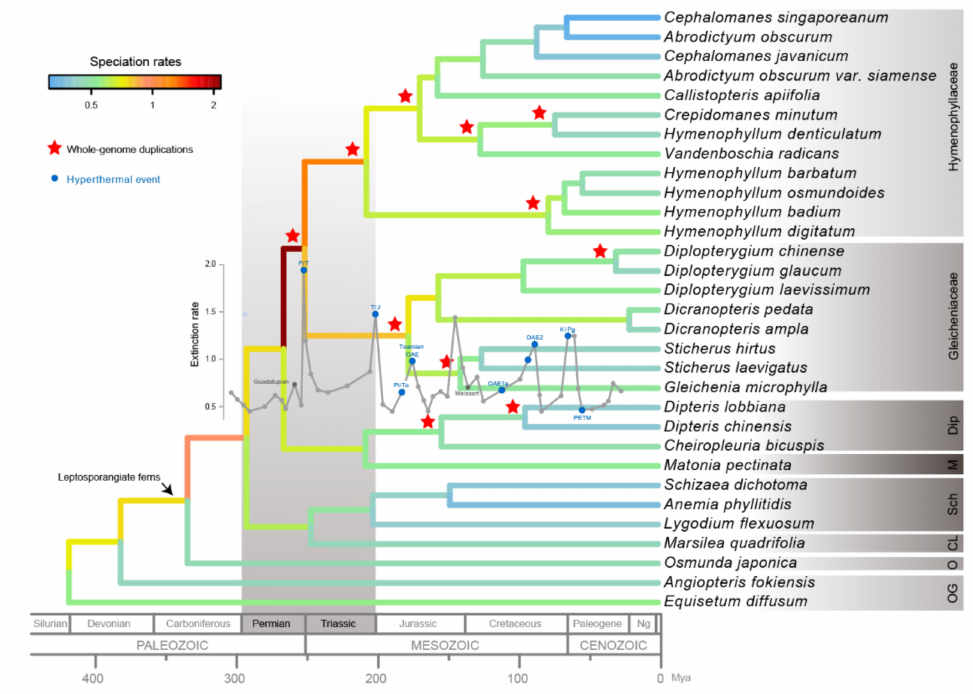
Figure 4. The evolutionary history of early leptosporangiate ferns. The bootstrap support (BS) value of each branch is 100 (not indicated in the species tree). The extinction rate was sourced from Clapham and Renne (2019). The red stars indicate the inferred whole genome duplication events. Abbreviations: K/Pg, end-Cretaceous; OAE, oceanic anoxic event; PETM, Paleocene–Eocene Thermal Maximum; Pl/To, Pliensbachian–Toarcian; P/T, end-Permian; T/J, end-Triassic; Dip, Dipteridaceae; M, Matoniaceae; Sch, Schizaeales; CL, core leptosporangiate; O, Osmundales; and OG,